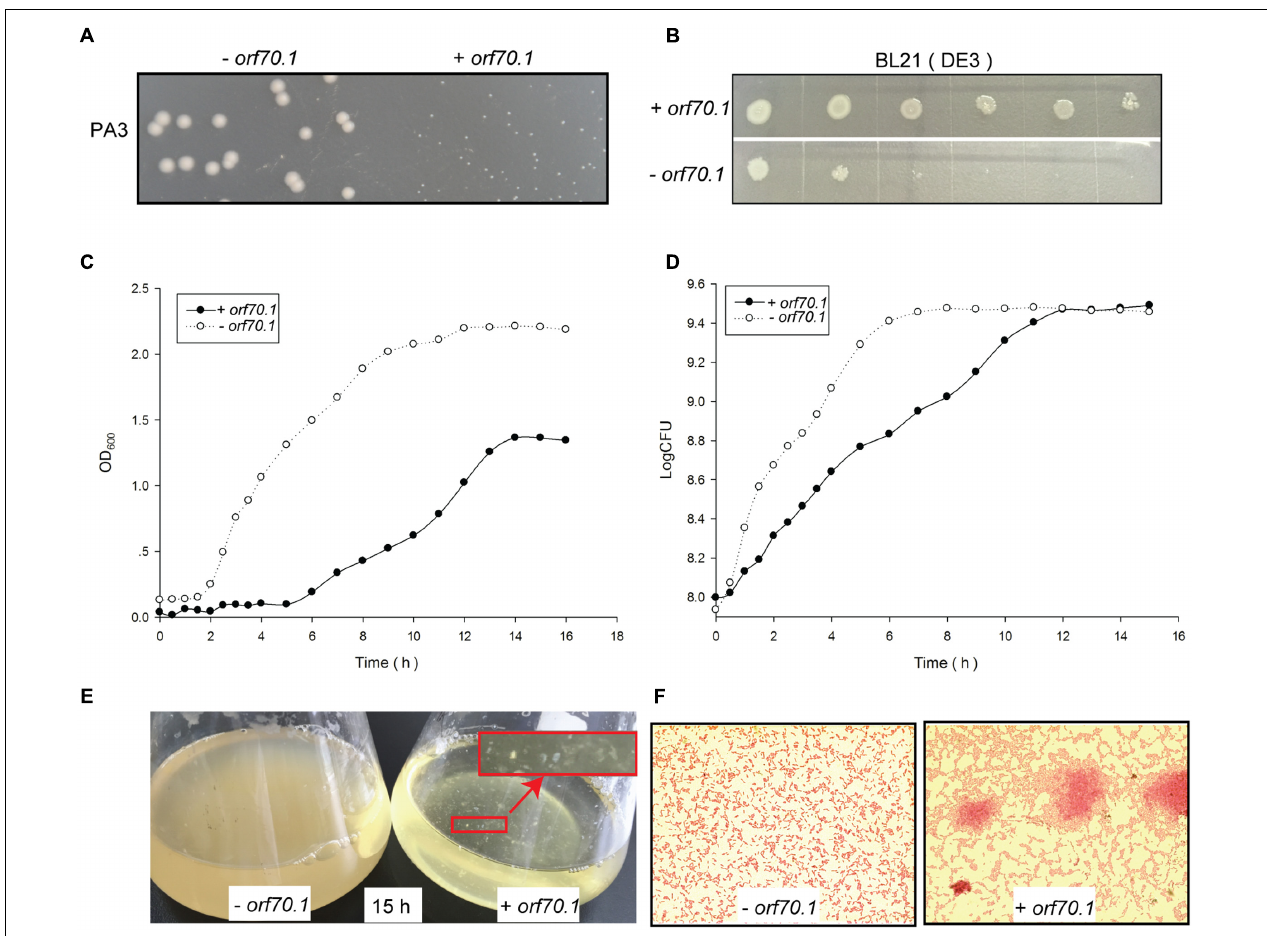
FIGURE 1 | Inhibition effects of gp70.1 on bacterial growth. (A) PA3 colonies on LB agar plate. (B) Inhibition of gp70.1 to E. coli BL21 (DE3). E. coli was 10-fold diluted serially and then inoculated on LB agar supplemented with 1mM IPTG. (C) Growth curve of PA3 based on absorbance value of OD 600 . (D) Growth curve of PA3 based on colony forming units. (E) Bacterial culture in LB broth cultured for 15 h. The red sign showed macroscopic cell aggregates of PA3/ orf70.1 , which were also observed in Gram stain. (F) Gram stain of bacteria cultured for 15 h. “ − orf70.1 ” shows bacteria transformed with an empty plasmid, while “ + orf70.1 ” shows bacteria with plasmid carrying orf70.1